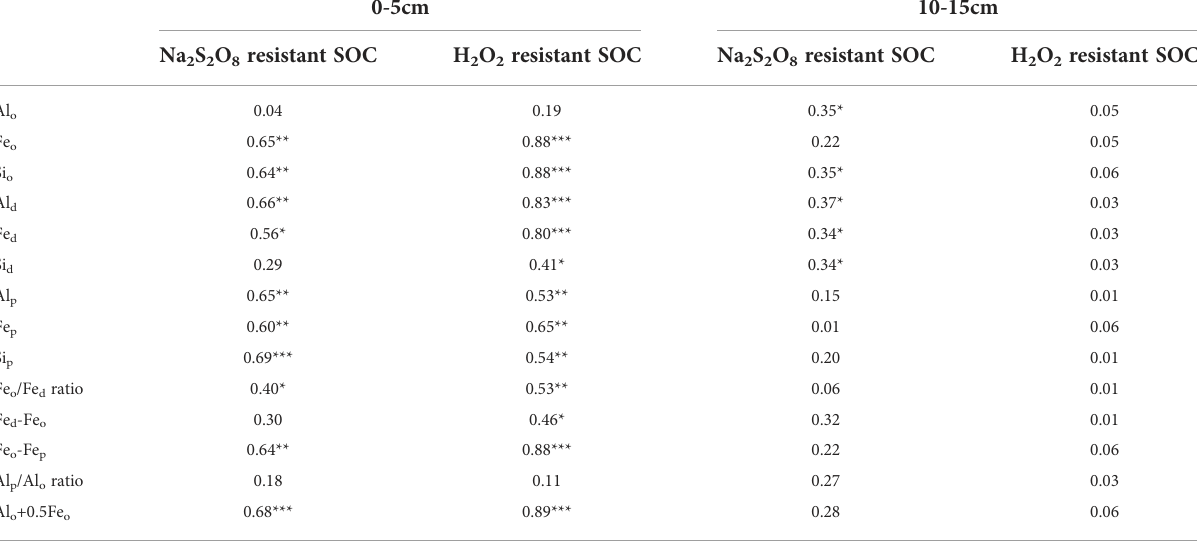
TABLE 3 Coef fi cients of determination (R 2 values) for single linear regressions of Na 2 S 2 O 8 resistant SOC and H 2 O 2 resistant SOC as a function of variables (g kg -1 ) in 0-5 and 10-15cm soils in four wetlands (Regressions for 5-10, 15-20 and 20-25 cm soils were not shown as the two stabilized SOC fractions were not statistically different among four